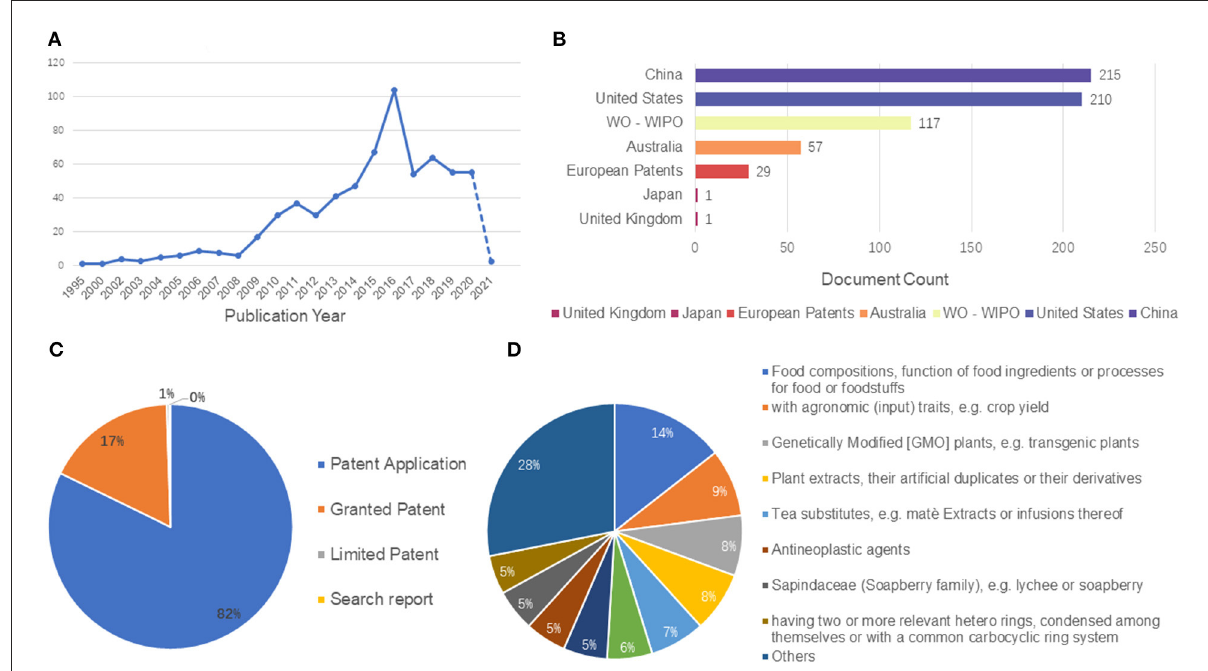
FIGURE6 The analysis of 630 patents browsed was obtained by Lens.org using the search term “Longan polysaccharide.” (A) Patent applications per years, (B) Document type, (C) Jurisdictions, and (D) CPC